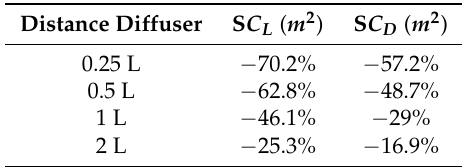
Figure 20. Streamlines of the velocity. Rear wing of the second car at a distance of 0.25 L, 0.5 L, 1 L, and 2 L as compared to the free stream case. Table 9. Percentage of change of the aerodynamic coefficients in the diffuser of the second car as regards the first